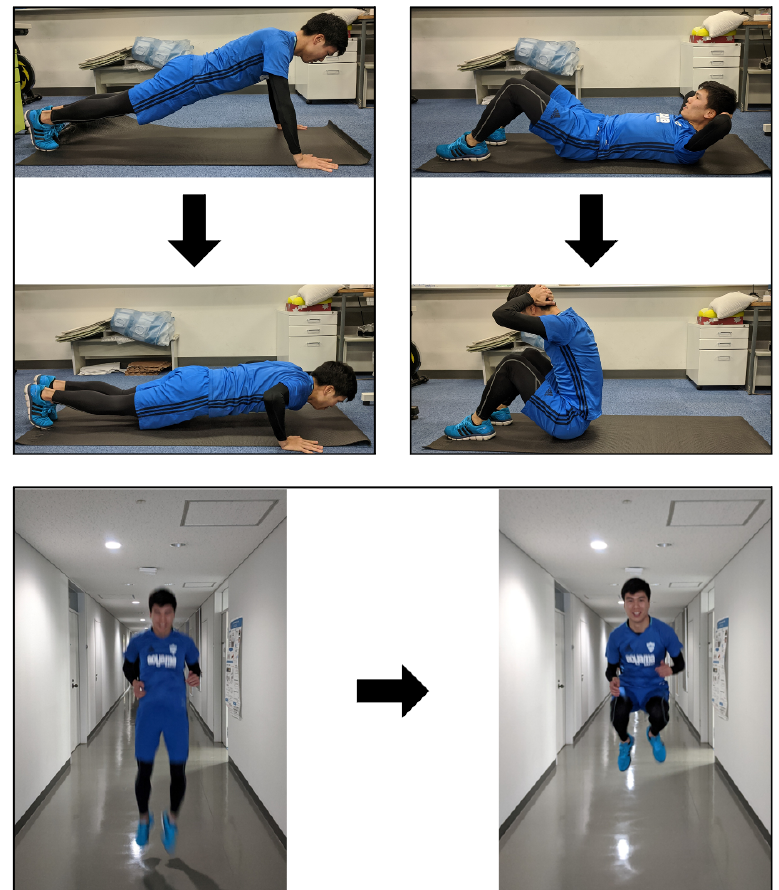
Figure 7. Pictures used to define push-ups ( top left ), sit-ups ( top right ), and jump ( bottom ) for subjects.